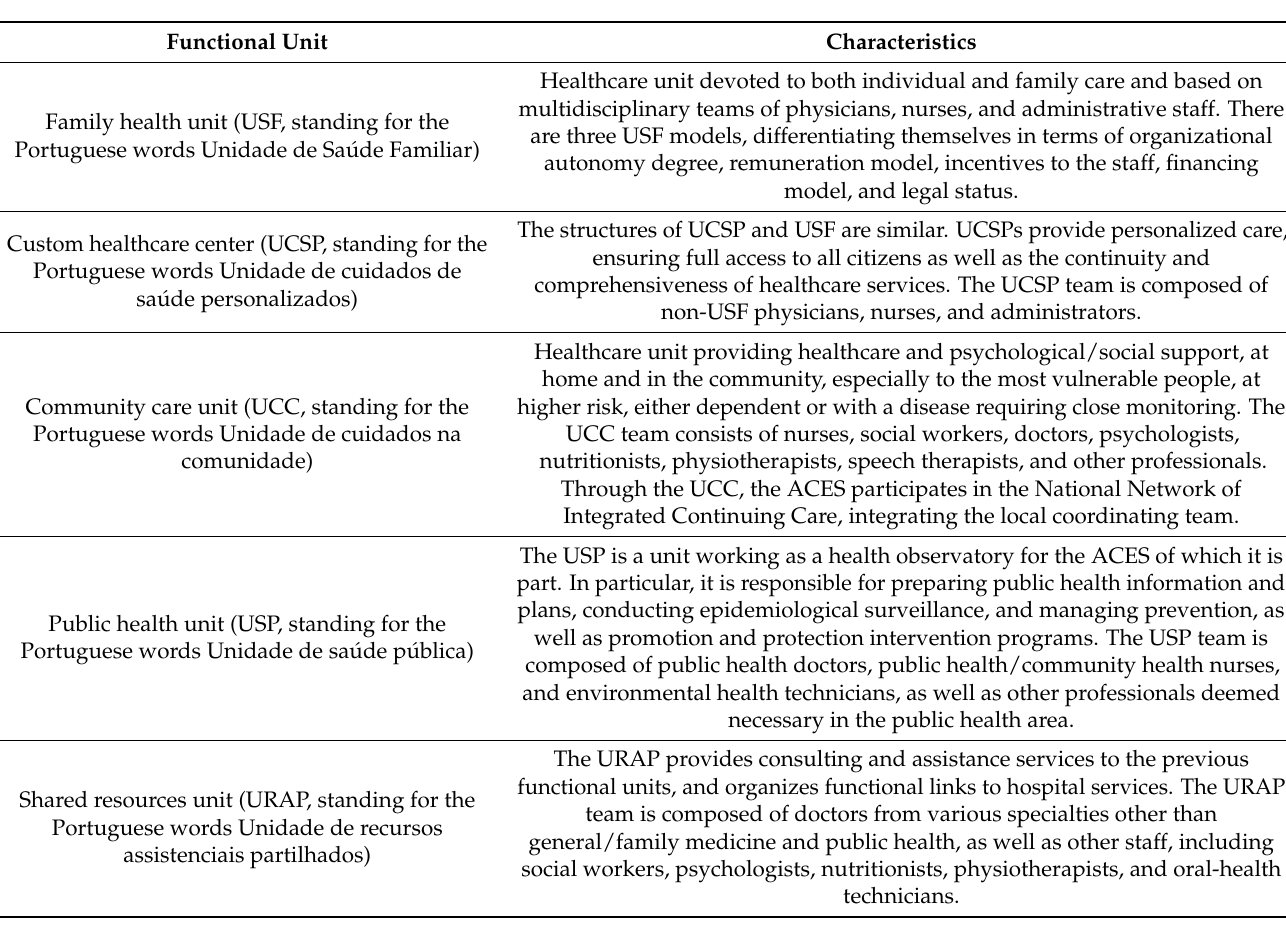
Table 2. Characterization of the functional units belonging to the Portuguese primary healthcare